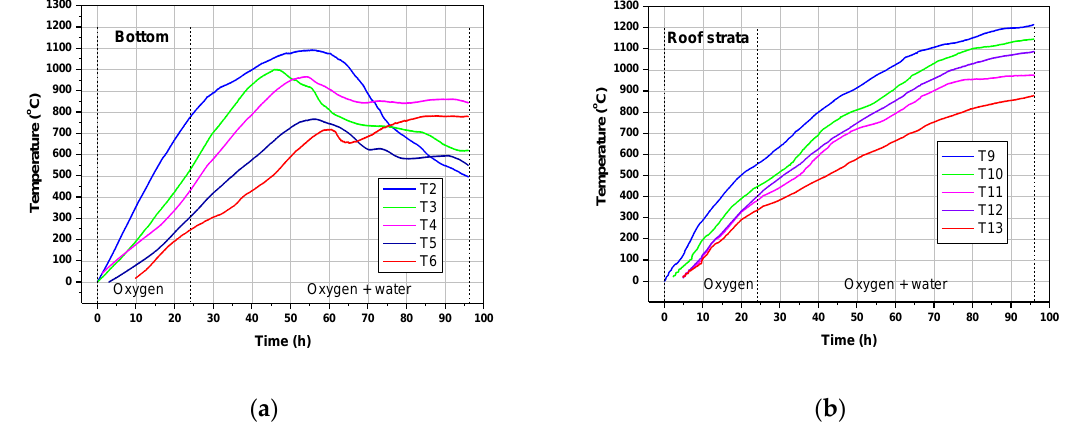
Figure 11. Distributions of temperatures during “Wesoła” hard coal gasification at 20 bar: ( a ) seam bottom, ( b ) roof strata.